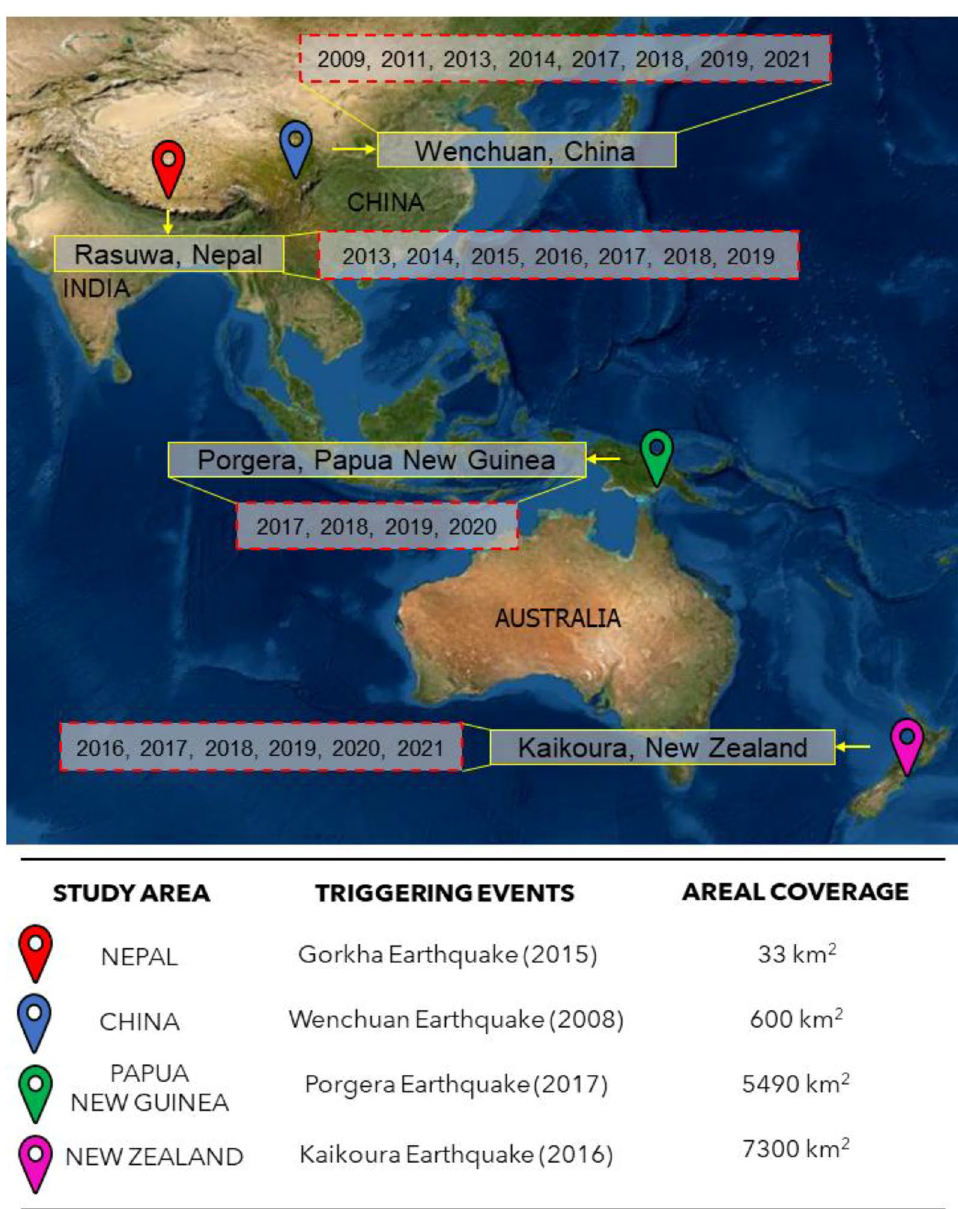
Figure 1. Overview of the study areas with the multi-temporal windows in the Asian-Pacific part of the world. Base map credits: www. arcgis. com/ apps/ mapvi